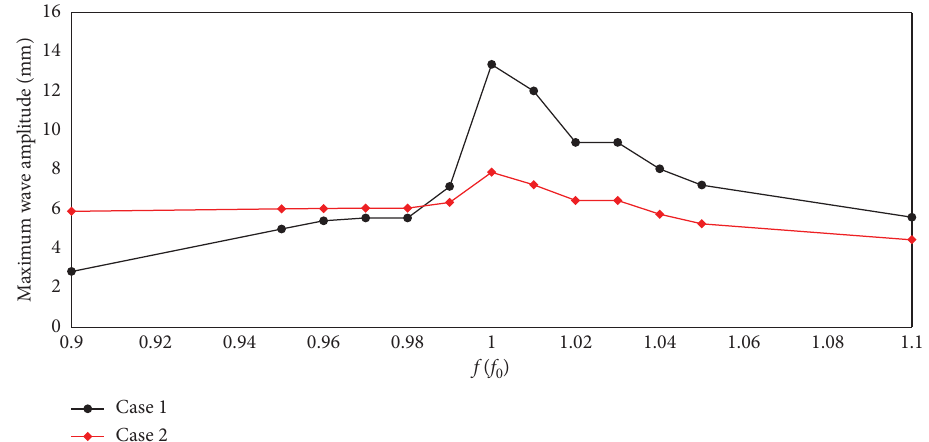
Figure 4: Comparison of the maximum wave amplitude response to frequencies between Case 1 and Case 2 under surge excitation.